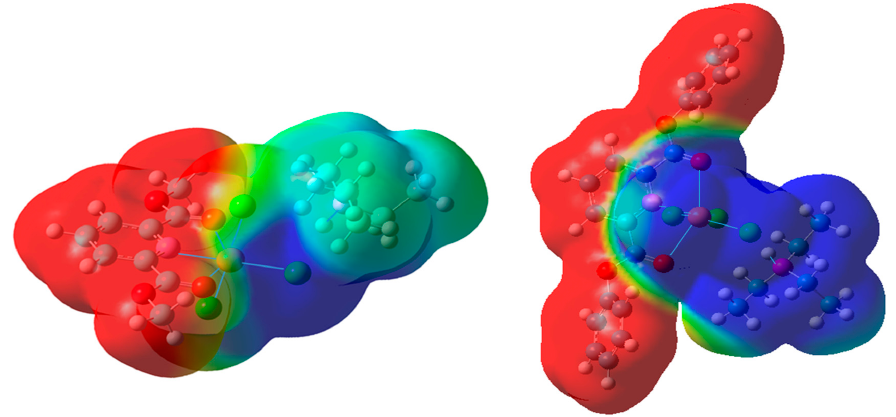
Figure 5. Electrostatic potential maps of (HNEt 3 )[Cu(pydicMe 2 )Cl 3 ] ( left ) and (HNEt 3 )[Cu(pydicPh 2 )Cl 3 ] ( right ) in the gas phase. Contours are color-coded from red (negative) to blue (positive).